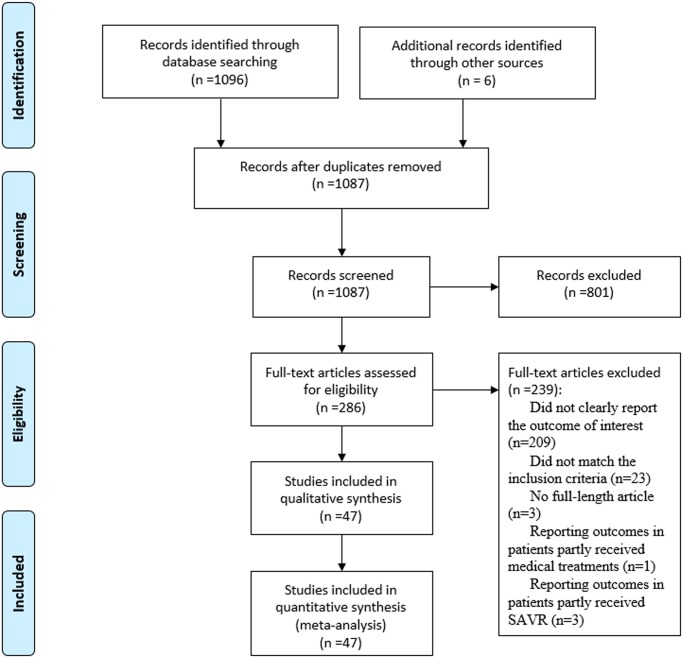
Meta-analysis flow diagram of study selection.